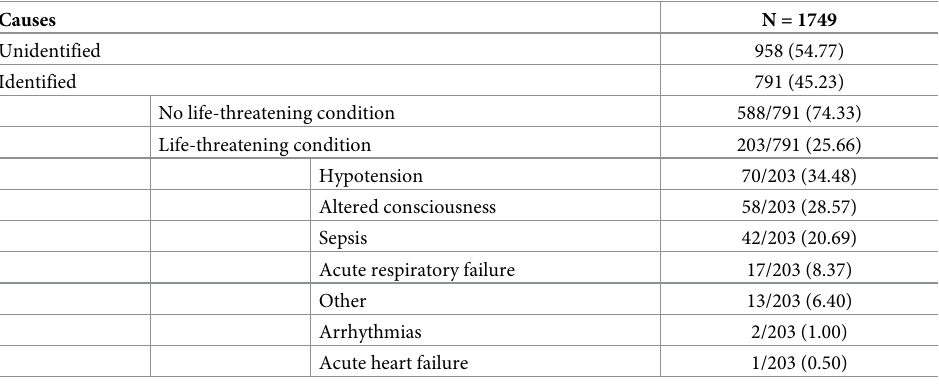
Table 3. Reasons for rapid-response team (RRT)